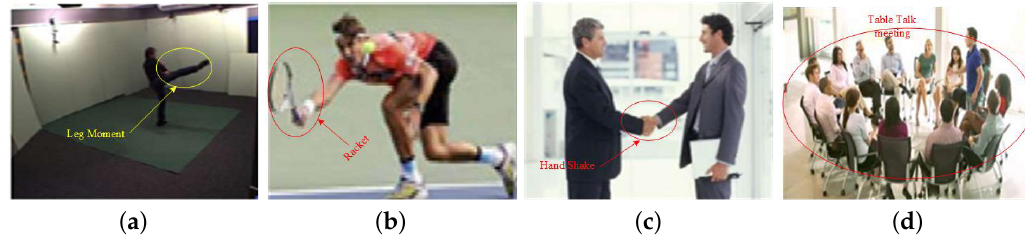
Figure 1. Different human activities based on labels: ( a ) gymnast actions; ( b ) a man playing with bat; ( c ) human-to-human interaction; and ( d ) a group of people writing a